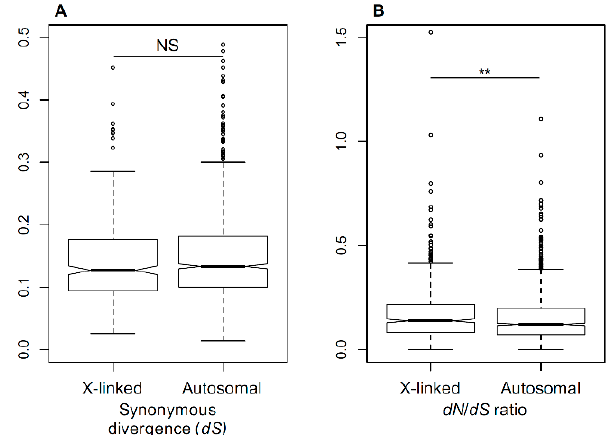
Figure 1. Evolutionary rates in Silene X-linked (X) and autosomal (A) genes. ( A ) Synonymous divergence between Silene latifolia and Silene vulgaris at X-linked and autosomal genes in S. latifolia . ( B ) Nonsynonymous ( dN ) to synonymous ( dS ) divergence ratio (dN / dS ) between S. latifolia and S. vulgaris genes. The sex-linked genes have significantly higher dN / dS ratio than the autosomal genes (Student’s test, ** p < 0.01).